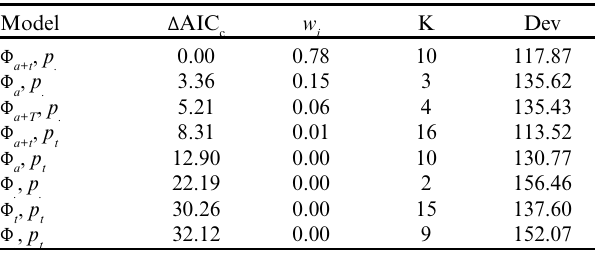
Table 3 . Model selection statistics for capture-resight data for hatch-year and after-hatch-year male Golden-cheeked Warblers ( Setophaga chrysoparia ) from study plot Thirteen B, Fort Hood Military Reservation, Texas, USA, 1992-2000. Model selection was based on change in Akaike’s Information Criterion corrected for small sample size ( Δ AIC ) and AIC weights ( w ) such that the c c i best-supported model had the smallest Δ AIC and the largest w . c i Φ - apparent survival probability, p - resight probability, a+t - age and time, a - age , t - time, . - constant, T - linear trend.